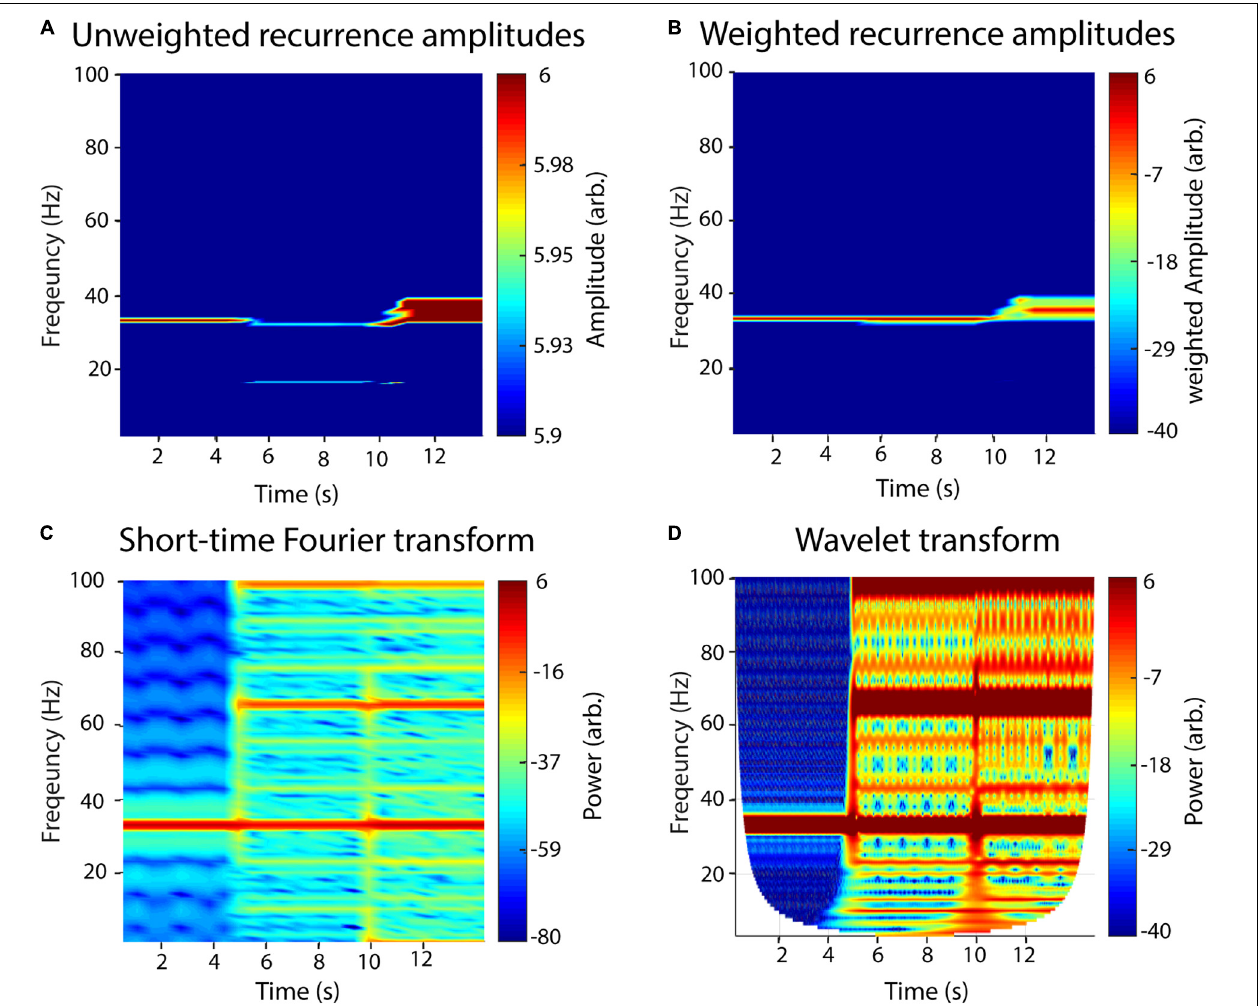
FIGURE 4 | A recurrence amplitude spectrum. The recurrence amplitude spectrum of a compound signal of three 33-Hz oscillatory signals of different shapes is shown. The first 5 s is composed of a sine wave, the next 5 s of a sawtooth wave, and the last 5 s of a rectangle wave. (A) Raw unweighted amplitudes. (B) Raw amplitudes were weighted with their respective probability densities. (C) Short-time Fourier transform of the same signal. Window length was set to 1 s with a 50% overlap. Note the spurious harmonics for the nonlinear waveform shapes, i.e., rectangle (5–10 s) and sawtooth shape (10–15 s). (D) Wavelet transform of the signal. Wavelet width was set to 30. Note the spurious harmonics for the nonlinear waveform shapes, i.e., rectangle (5–10 s) and sawtooth shape (10–15